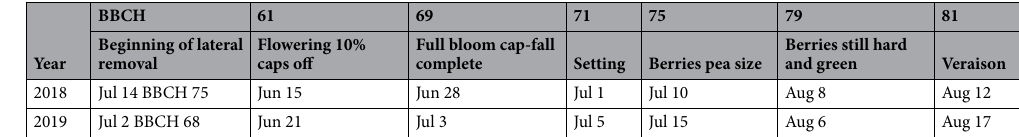
Table 2. Treatment timing and key phenological growth stages in 2018 and